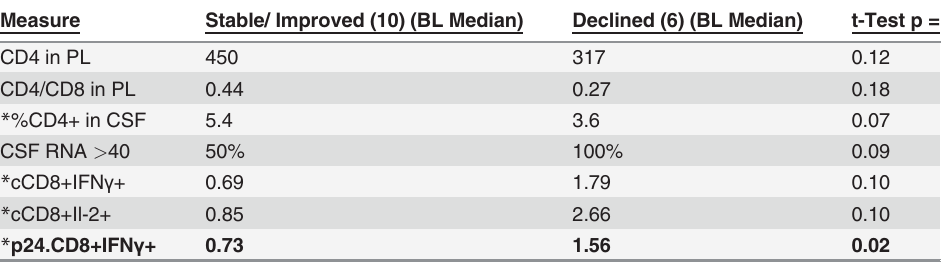
Table 7. The most signi fi cant predictor of neurocognitive decline was higher CD8+IFN γ response to HIV p24 antigen at baseline.